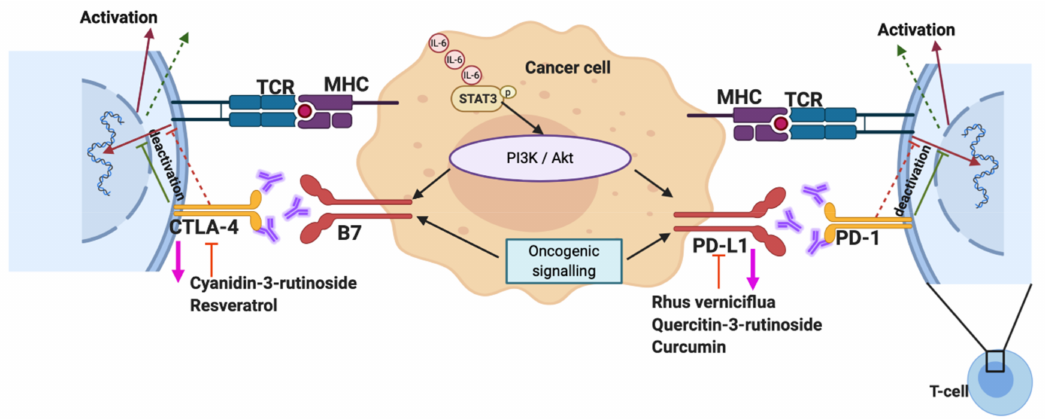
Figure 3. Mechanism of the phytochemicals targeting the immune checkpoint receptors. T-cell receptor: TCR; major histocompatibility complex: MHC; cytotoxic T-lymphocyte-associated protein 4: CTLA-4; programmed death ligand 1: